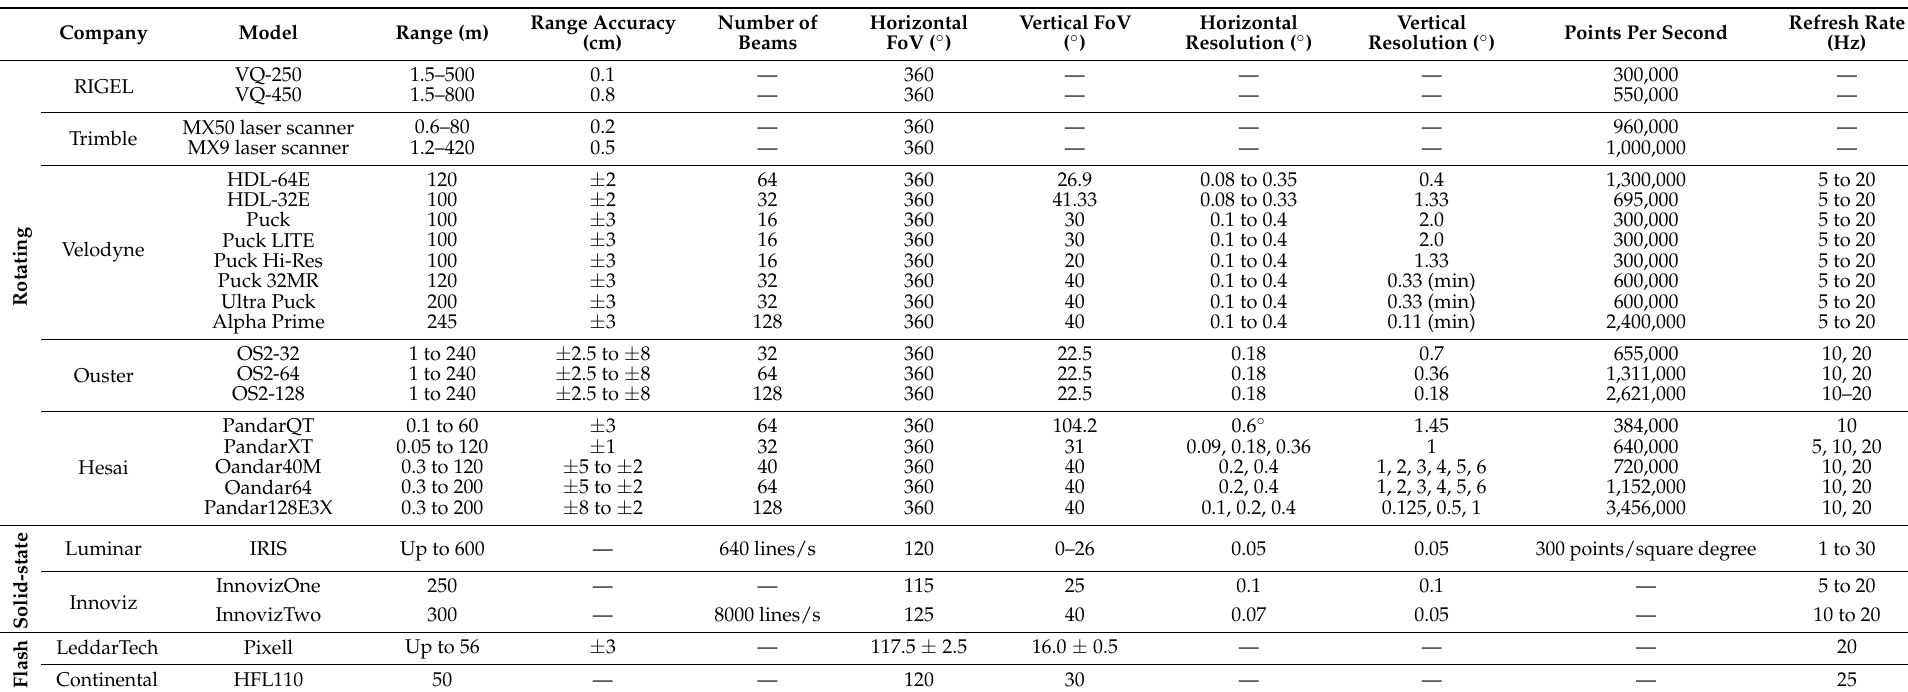
Table 2. Specifications of different LiDAR